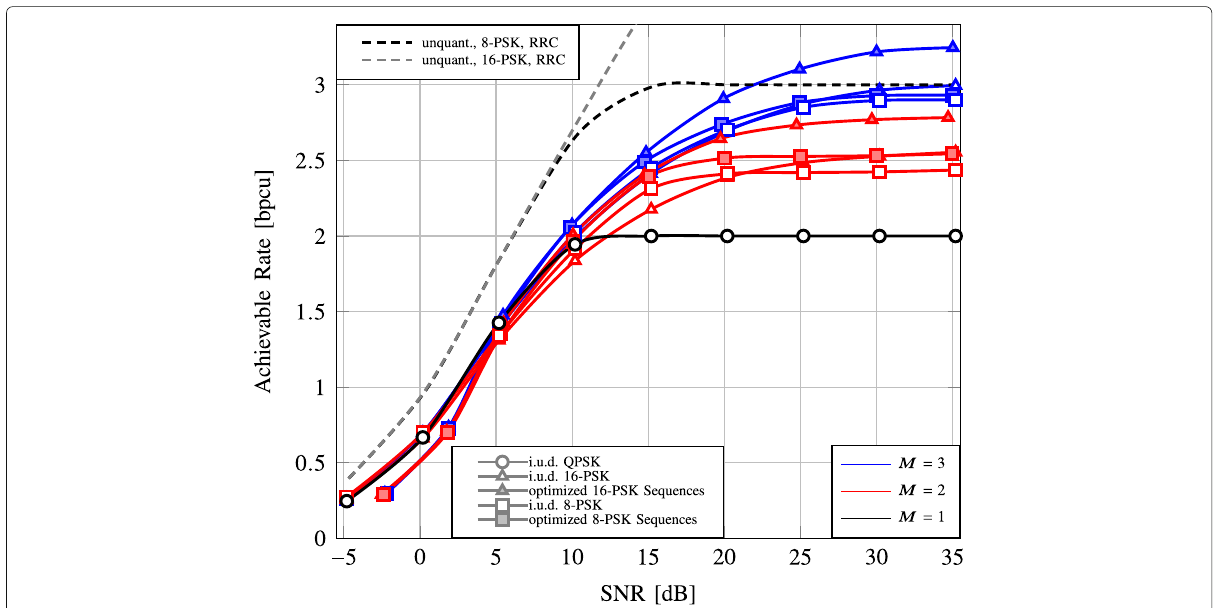
Fig. 13 Achievable rate versus SNR considering PSK transmit